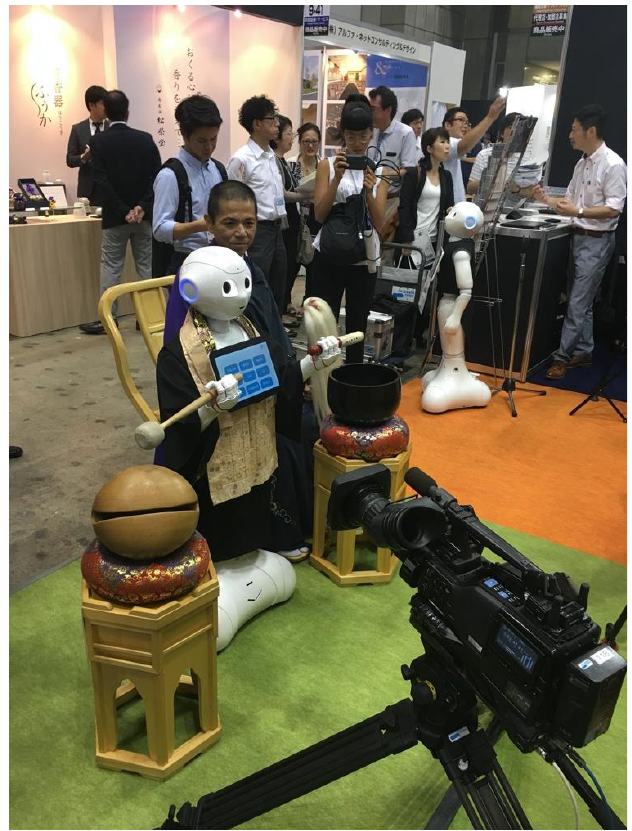
Figure 1. Pepper performing sutra recitation, Tokyo, 2017. (Photo: Hannah Gould) At the 2017 Life Ending Industry Expo ( エンディング産業展 Endingu Sangyōten ), the country ’ s largest